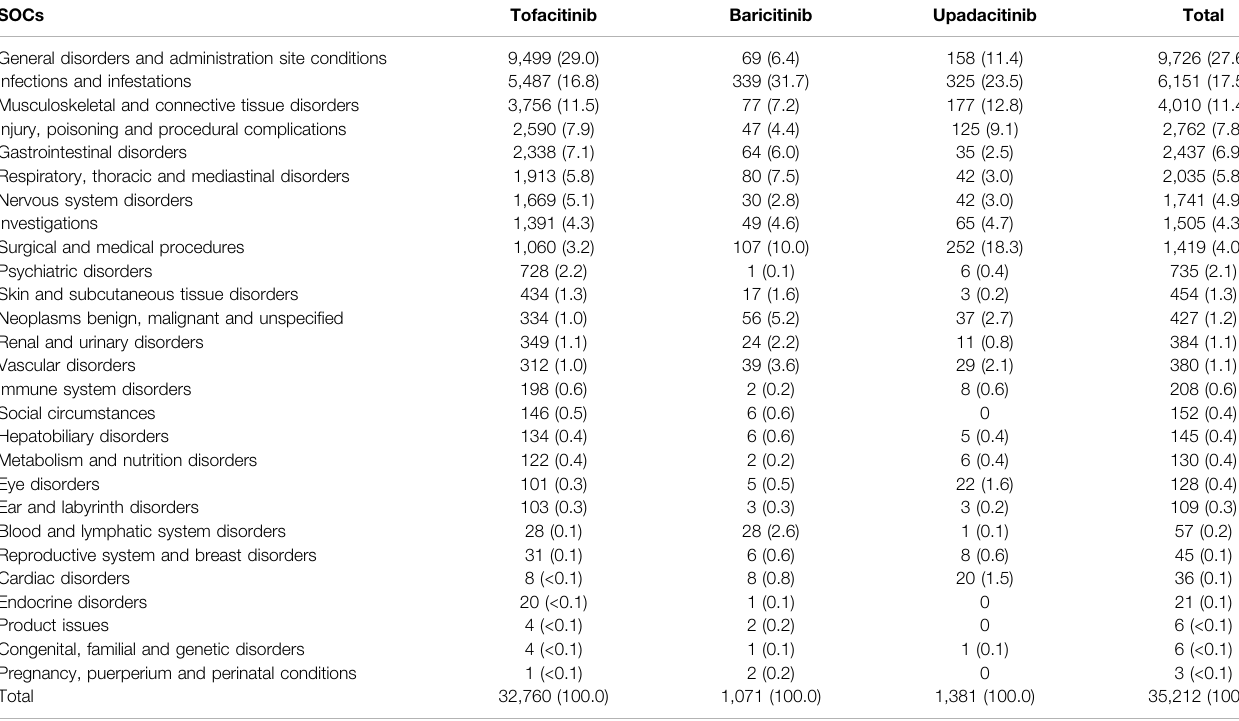
TABLE 2 | Distribution of System Organ Classes (SOCs) for potential adverse events of JAK inhibitors used for rheumatoid arthritis from the FAERS database. SOCs Tofacitinib